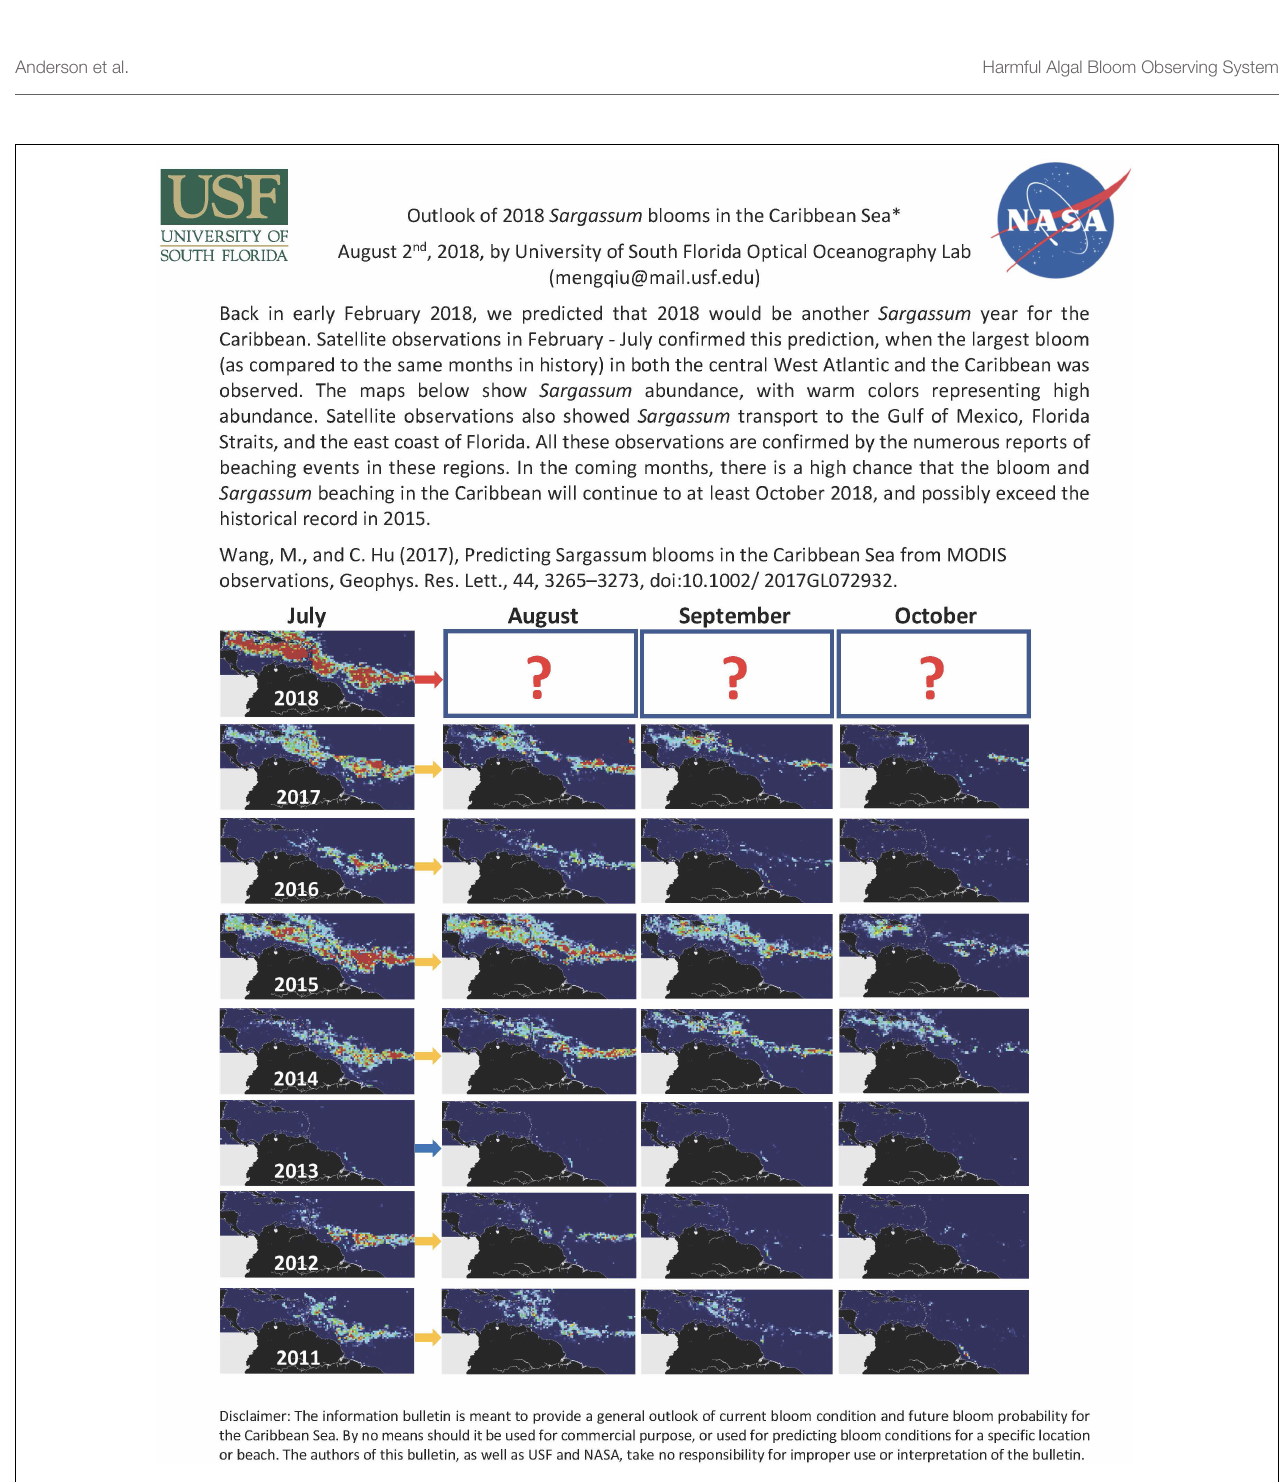
FIGURE 4 | University of South Florida Sargassum Outlook monthly bulletin for Sargassum abundance in the Caribbean from SaWS (Satellite-based Sargassum Watch